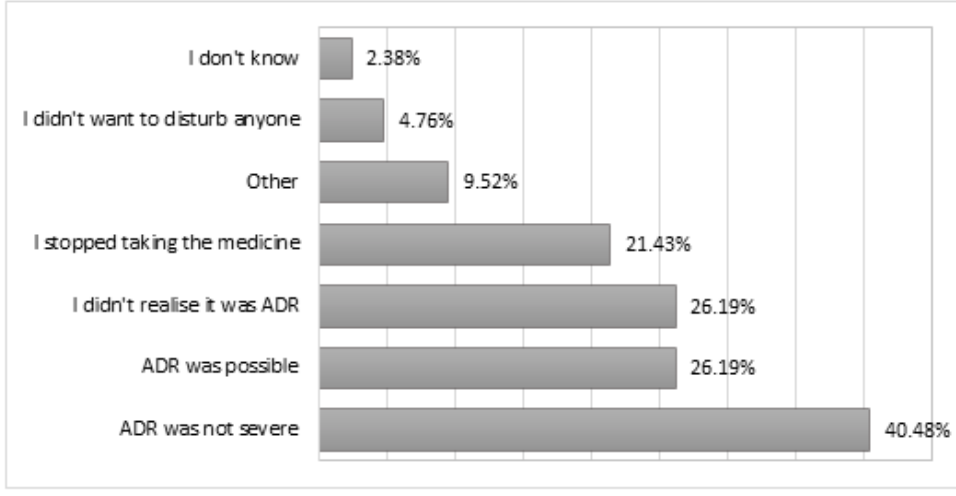
Figure 1. Reasons and actions taken by consumers who experienced ADR. Multiple answers.